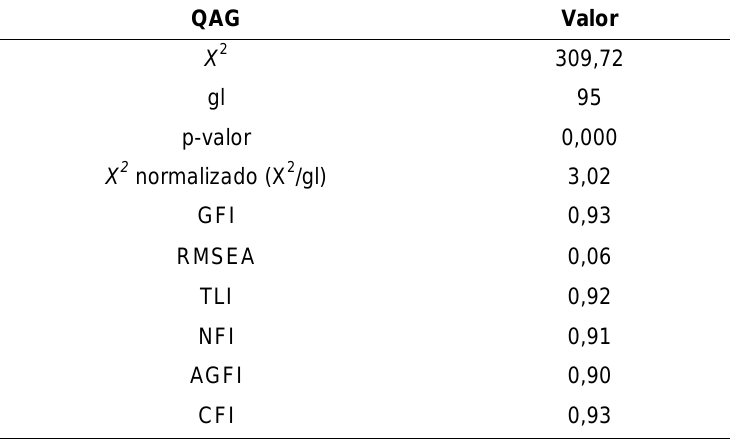
Tabela 3. Índices de ajustamento da versão brasileira do Group Environment Questionnaire (GEQ) para a amostra de